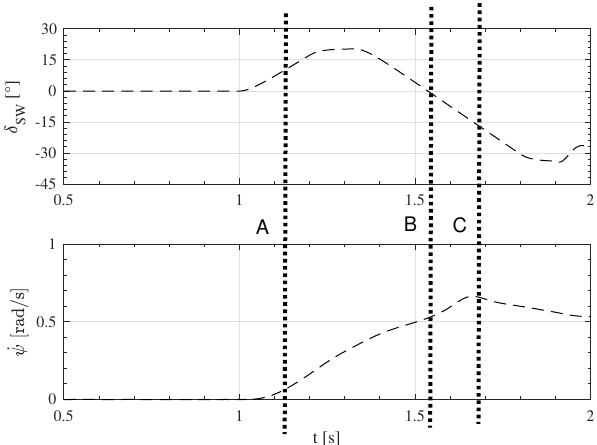
Figure 8. Time history of vehicle steering wheel angle δ SW and yaw rate ˙ ψ at the beginning of a drift